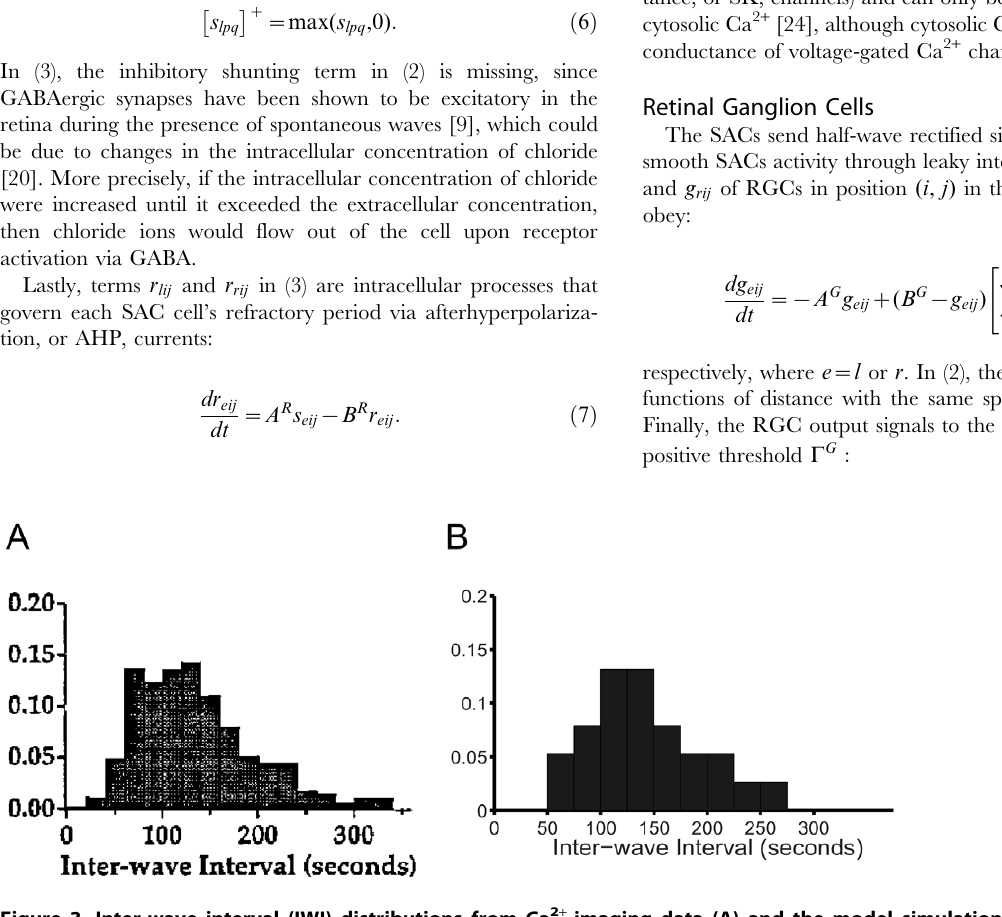
Figure 3. Inter-wave interval (IWI) distributions from Ca 2 + -imaging data (A) and the model simulation (B). A comparison the IWI distributions from model simulations with Ca 2 + -imaging data [2]. The Ca 2 + -imaging data is derived from multiple retinas. Likewise, the simulation results are an aggregate of multiple simulations that used different values of A R (6,6.15,6.3,6.45,6.6,6.75,6.9,7.05). [Experimental data in (A) are reproduced with permission from [2].]